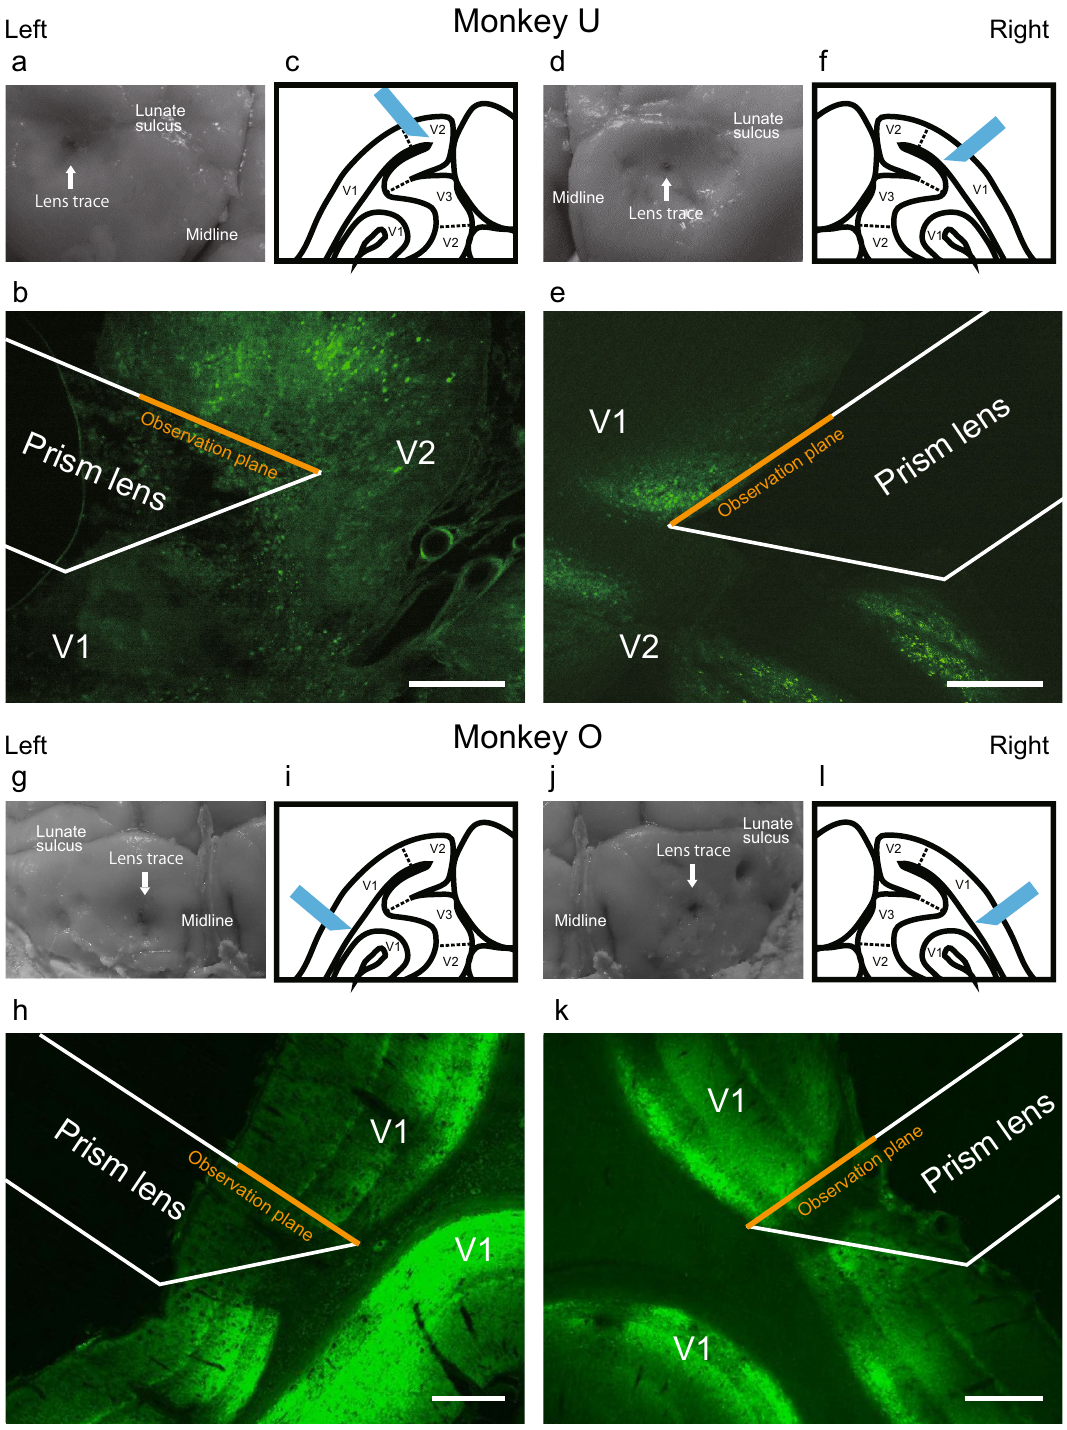
Figure 2. Immunohistochemistry and lens position. ( a ) Lens trace in the postmortem brain (left hemisphere) of Monkey U. White arrow indicates the hole where the lens punctured the brain. ( b ) 2D reconstruction of the position of the prism lens depicted on a micrograph of an immunostained brain section. Scale bar: 500 µm. ( c ) Illustration of lens position based on ( b ). ( d – l ) The corresponding figures to ( a – c ) for the right hemisphere of Monkey U and the left and right hemispheres of Monkey O. V1, primary visual cortex; V2, secondary visual cortex, V3, third visual